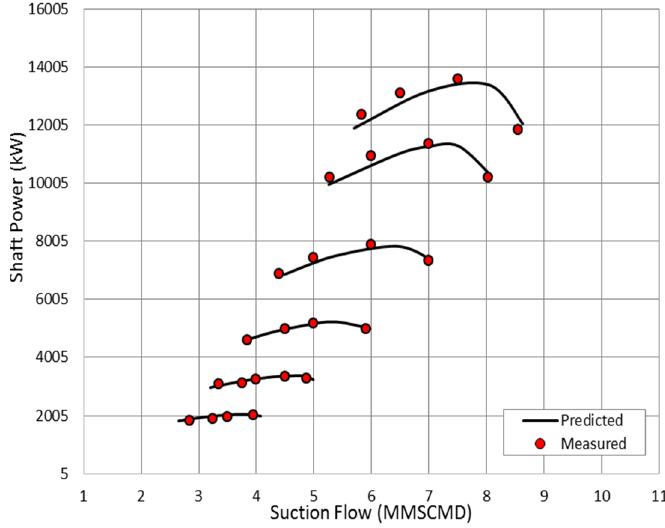
Figure 5. Comparison between the predicted and measured shaft